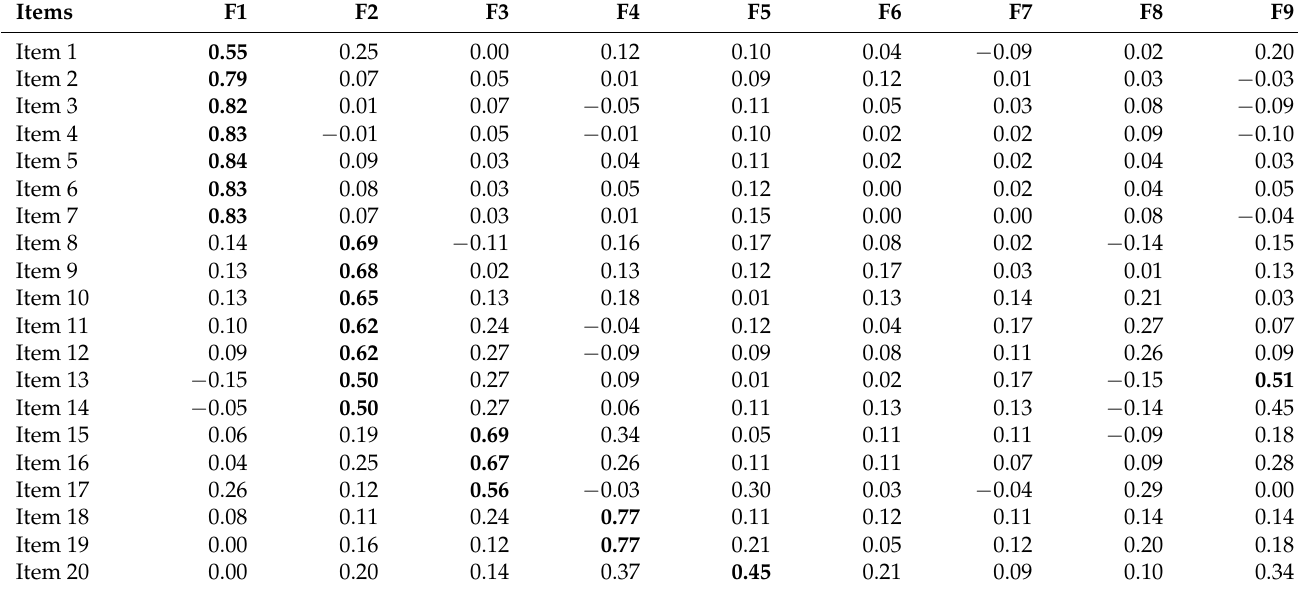
Table 3. Exploratory factor analysis for the factors structure of the GSCS-Chinese